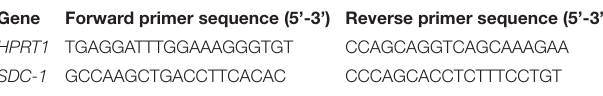
TABLE 1 | Primers used for quantitative polymerase chain reaction (qPCR; human